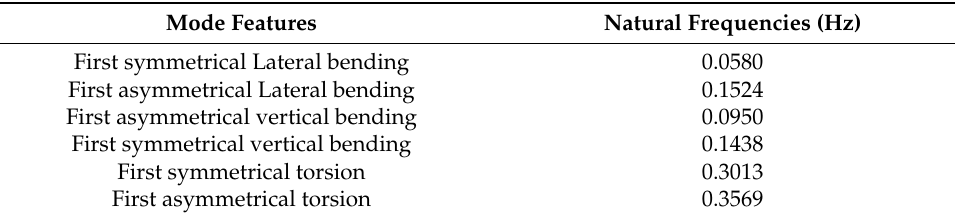
Figure 2. The finite element model of the bridge. Table 1. Bridge structural natural frequencies and mode features.